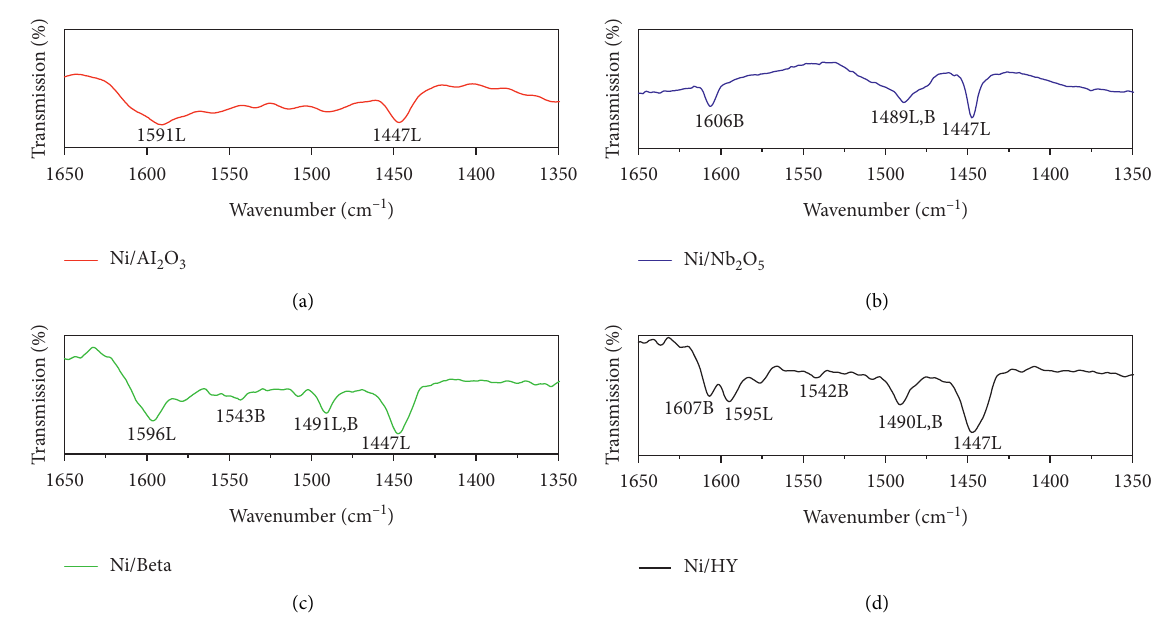
Figure 7: Pyridine-FTIR of the Al 2 O 3 , Ni/Nb 2 O 5 , Ni/Beta, and Ni/HY catalysts.